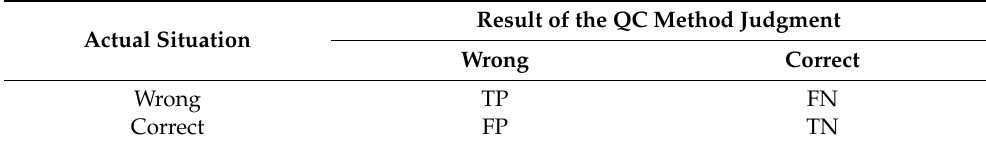
Table A1. The confusion matrix of the result of the QC method judgment. Actual